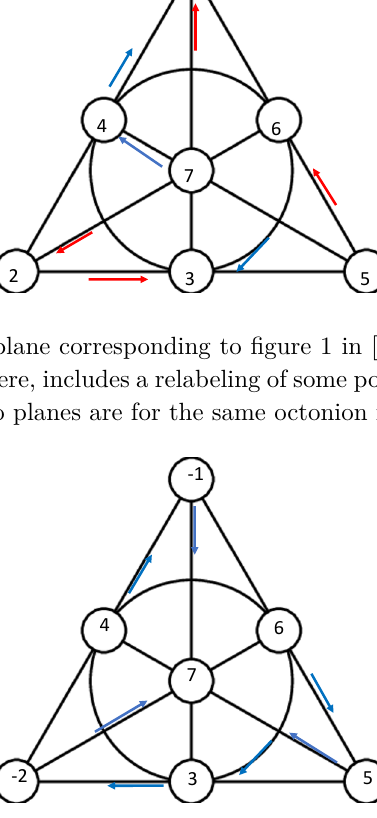
Figure 24 . An oriented Fano plane corresponding to figure 23, where we have flipped the signs on 1 and on 2 . Simultaneously we have flipped the direction of the red arrows in figure 23 when the line has an odd number of sign changes. This Fano plane is for the same octonion multiplication table in figure